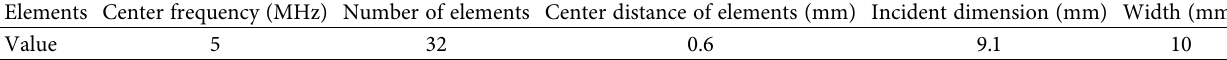
Figure 3: Actual testing: (a) C scanning; (b) sectorial scanning. Table 1: Parameter configuration of Olympus-linear 5L32-A11 T55 ° .